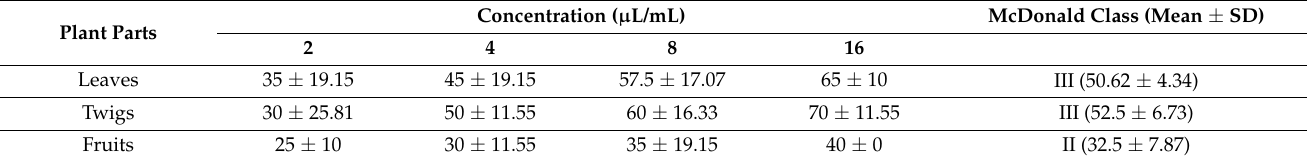
Table 6. Repulsion means percentages of Eucalyptus gunnii essential oils against Callosobruchus maculatus adults classified according to